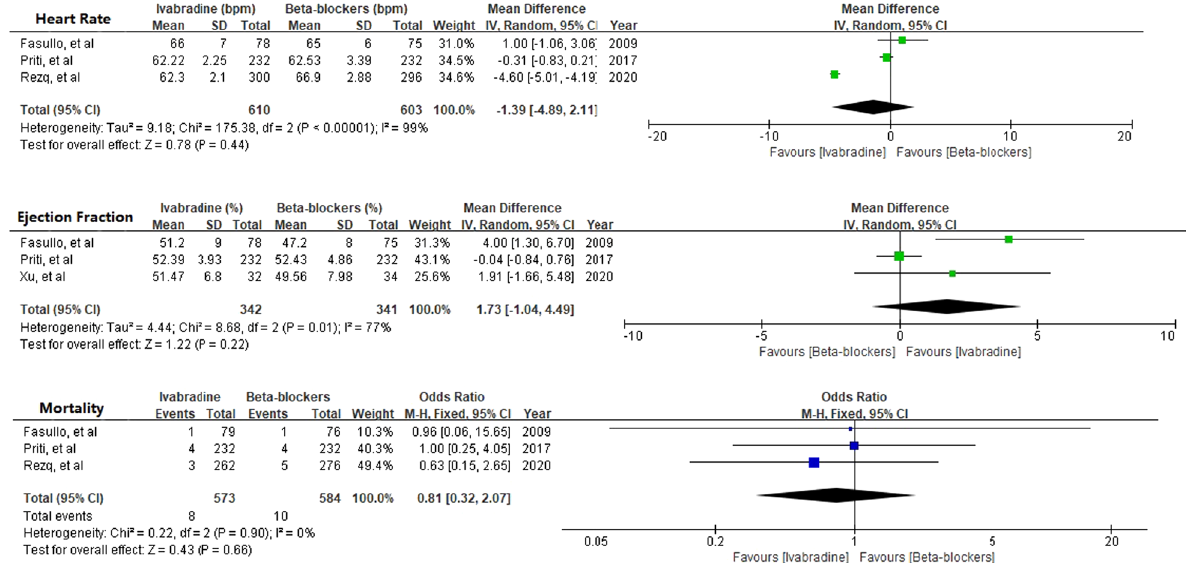
Fig. 8 Comparison of the safety and efficacy of Ivabradine vs.